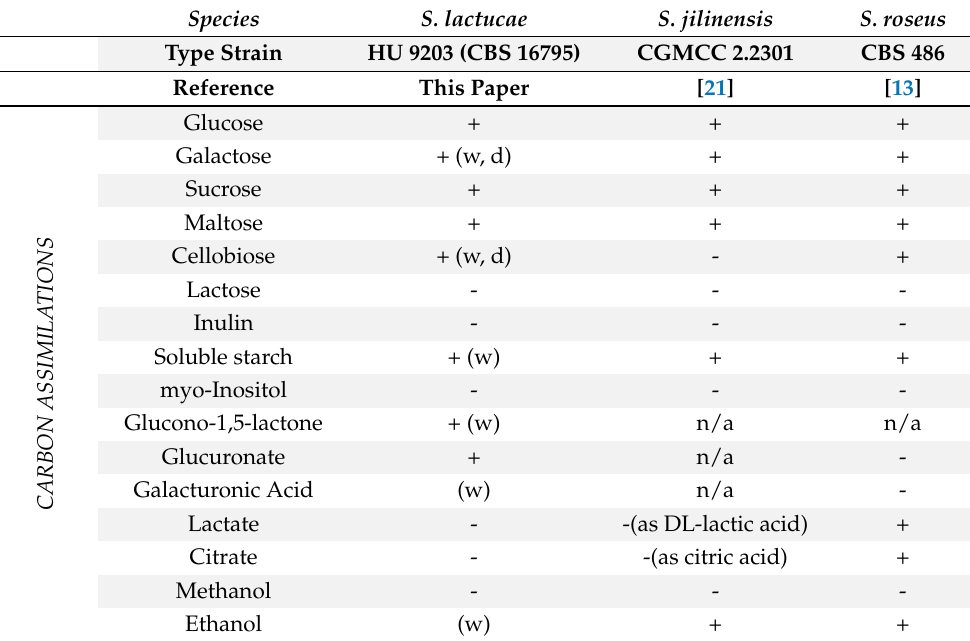
Figure 4. Sporobolomyces lactucae , micromorphological characteristics. Scale bar = 20 µm. Clockwise from top left: ( A – C ) Cells of S. lactucae at 400× magnification, incubated for 7 days on CMA as a Dalmau culture at ambient conditions (25 °C). Ballistoconidia arising from sterigmata are denoted with arrows. ( D ). Cells of S. lactucae grown in YM broth for 7 days in ambient conditions (25 °C). Cells were mounted on 2% potassium hydroxide for microscopy. Table 2. Assimilation and physiological results of S. lactucae and closely related species S. jilinensis and S. roseus . Weak assimilation is denoted with “w”; delayed growth with “d”; and variable growth with “v”.